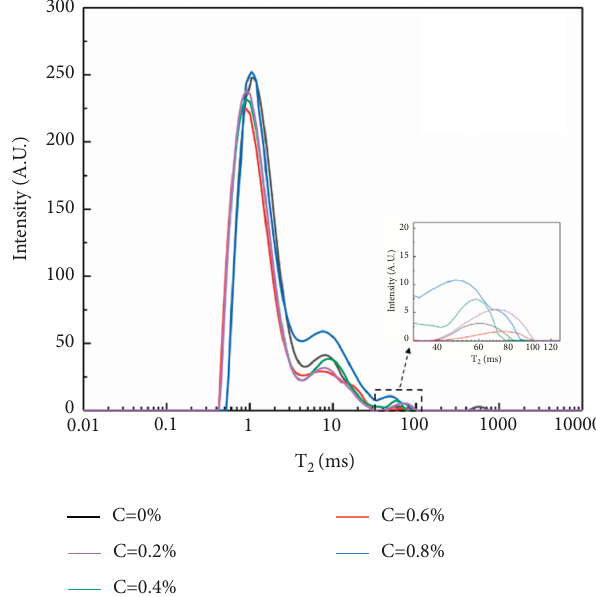
Figure 17: Distribution of T 2 spectrum for different fiber ratios.